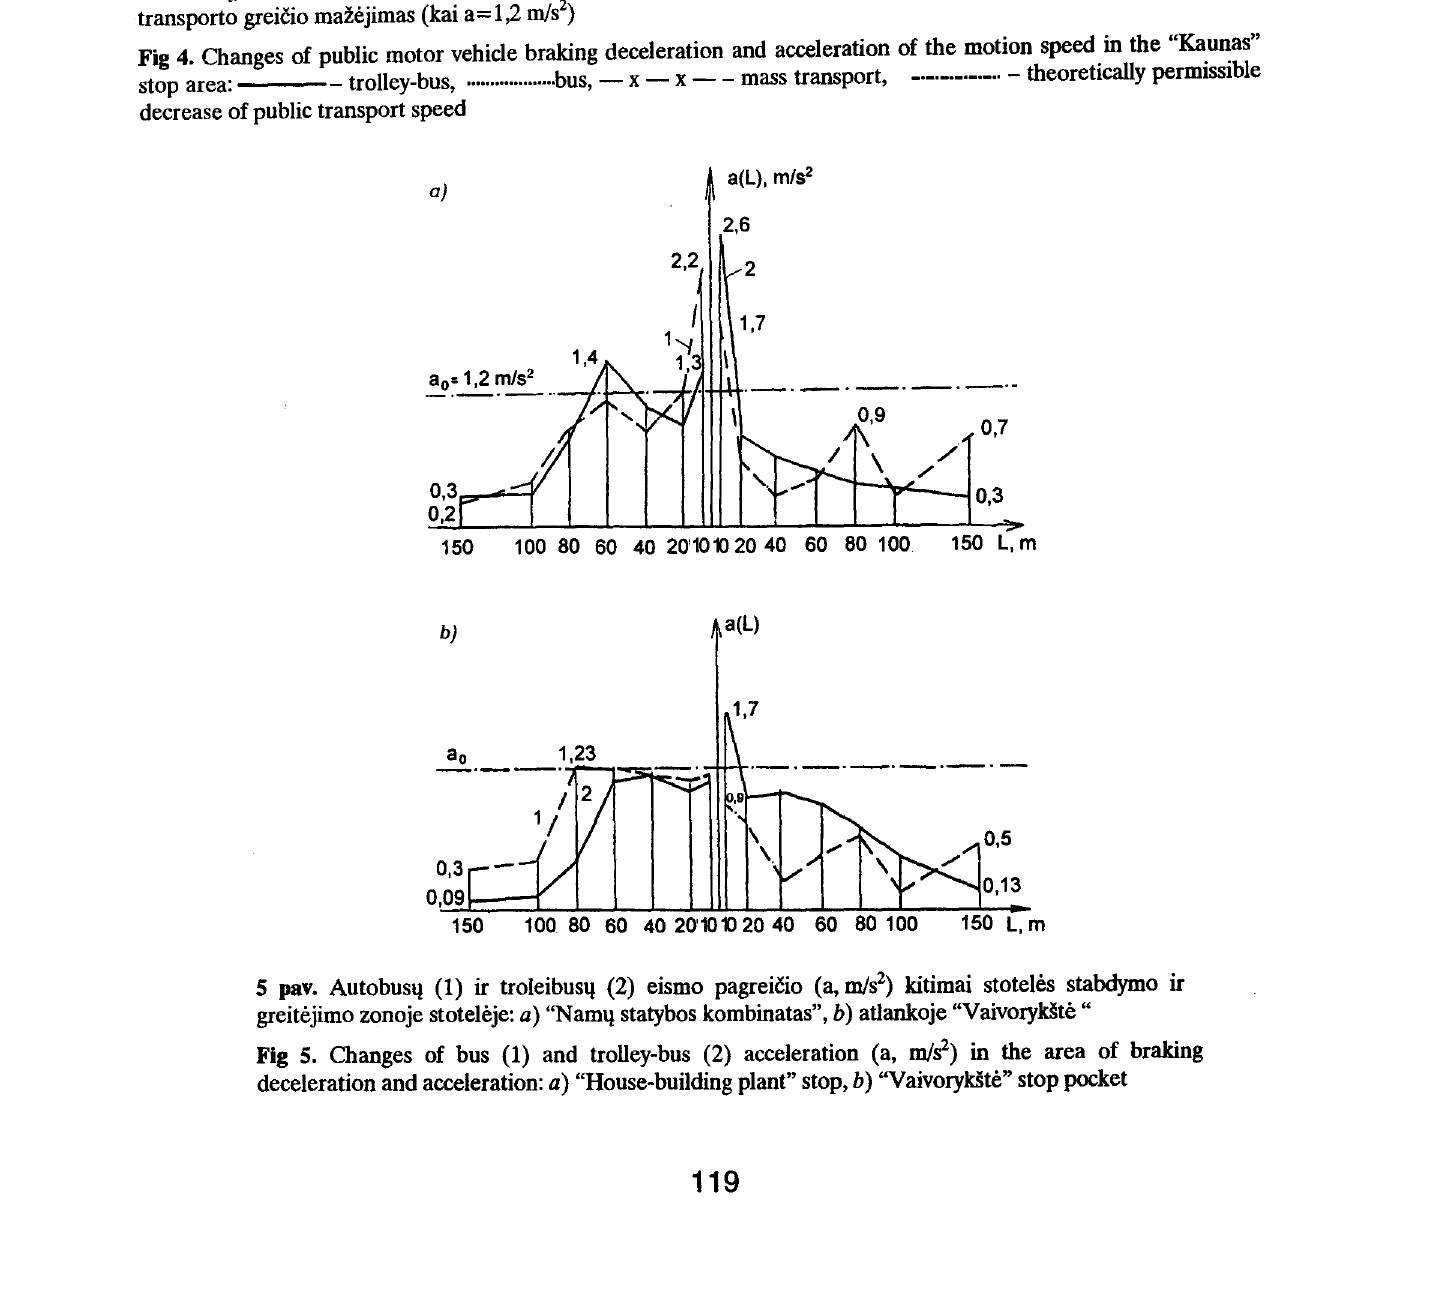
Fig 4. Changes of public motor vehicle braking deceleration and acceleration of the motion speed in the "Kaunas" stop area: